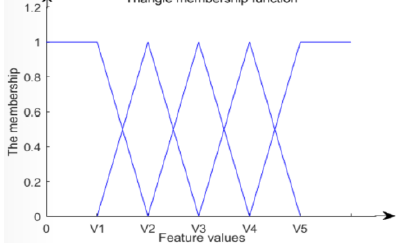
Figure 3. Triangle membership